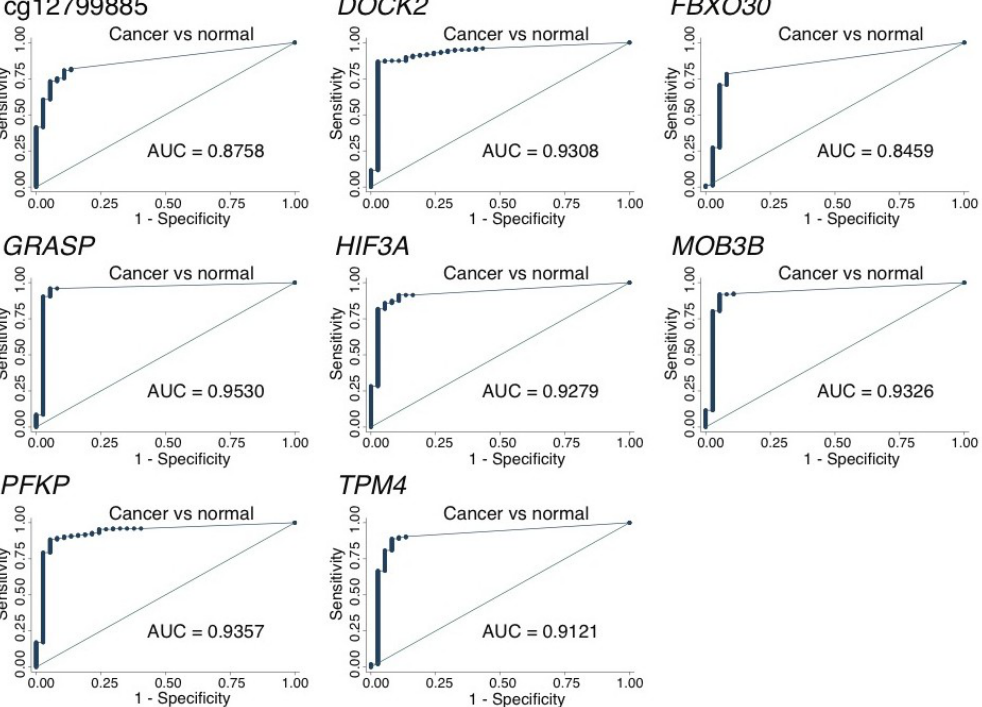
Figure 4. Diagnostic potential of selected methylation biomarker candidates. Receiver operating characteristics (ROC) curve analysis of the radical prostatectomy (RP) tissue samples ( n = 197) as compared to the nonmalignant prostate tissue samples (28 AN and 9 BPH). AUC: Area under the curve.